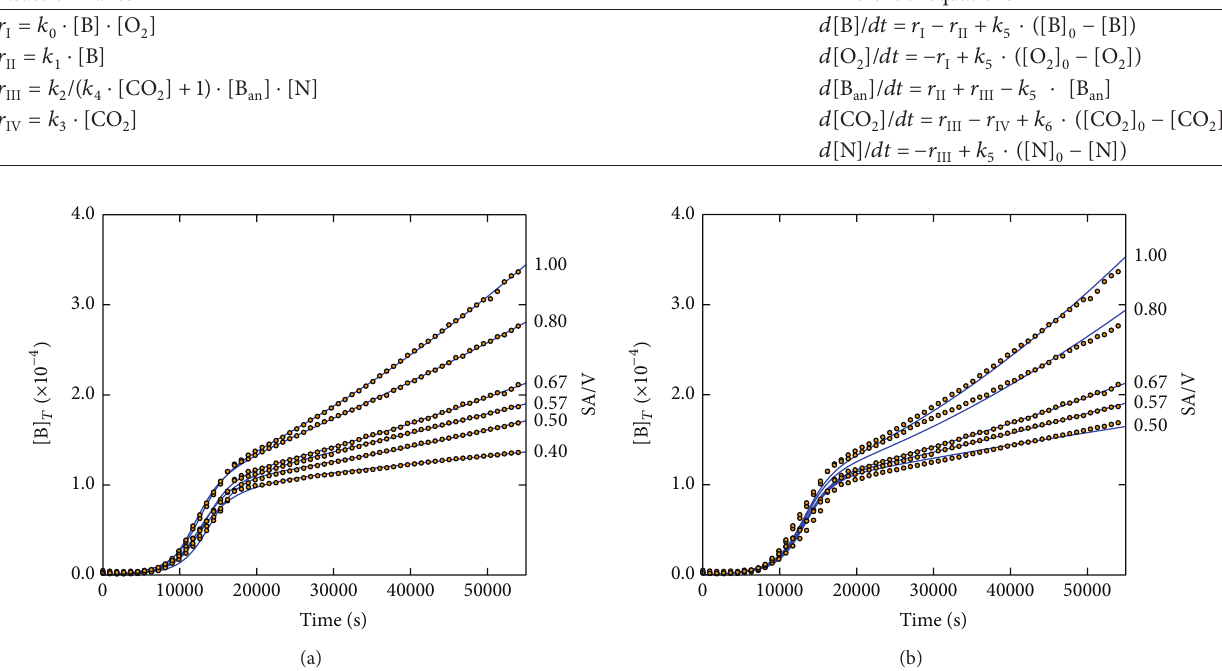
Table 1: Kinetic setup of the CKA model. The parameters 𝑘 5 and 𝑘 6 are flow rate constants to simulate chemostat conditions or the inflow into the system. [B] of CO 2 observed optical densities were taken as directly proportional to the total bacteria concentration [ B ] 𝑇 = [B] + [B Reaction fluxes